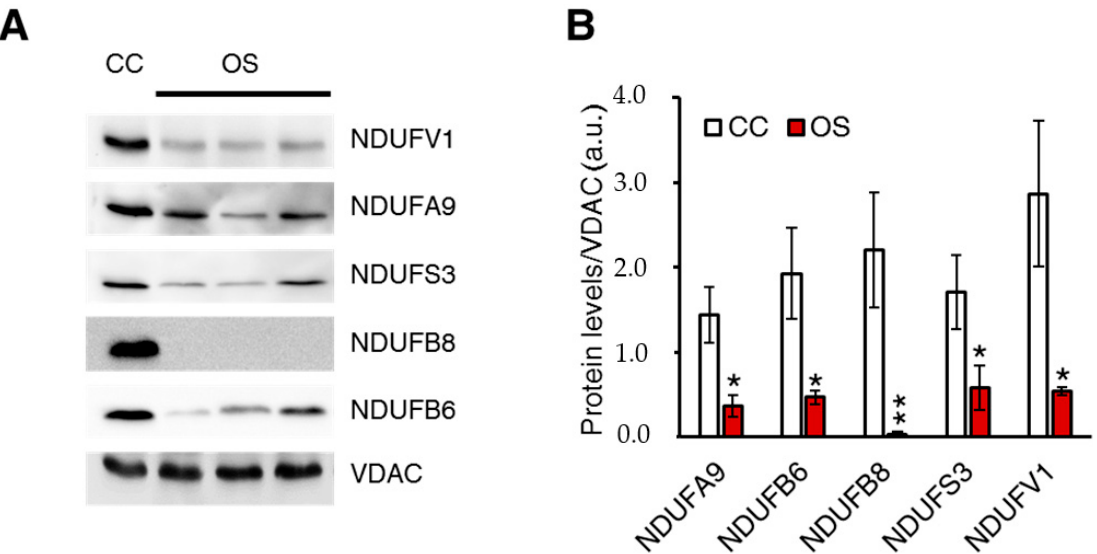
Figure 2. ND1 ablation impacts on steady state levels of nDNA-encoded complex I (CI) subunits. ( A ) Immunoblotting of CI nuclear-encoded subunits in crude mitochondria from control (CC) and three different ND1-null (OS) cybrids. VDAC1 was used as a loading control. One representative experiment of three is shown. ( B ) Densitometric quantification of western blot analysis of CI nuclear-encoded subunits. Data are mean ± SEM ( n = 3, * p -value < 0.05; ** p -value <